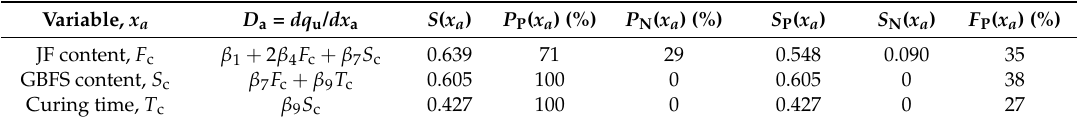
Table 8. Summary of the sensitivity analysis results with respect to Equation